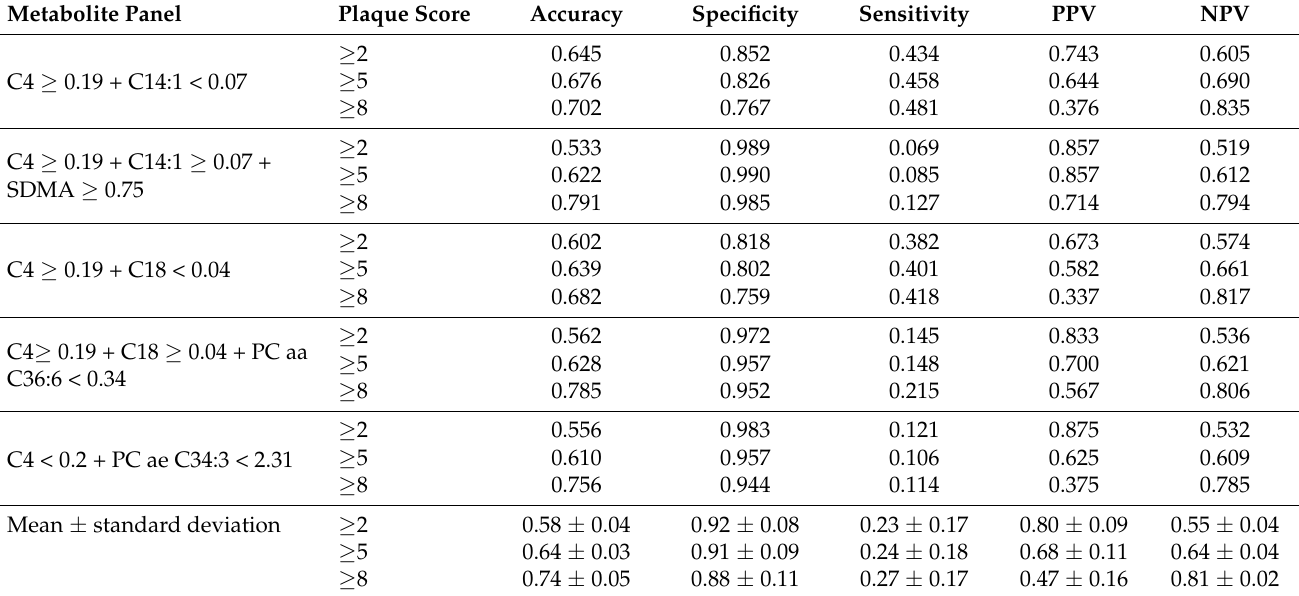
Table 3. Performance metrics of metabolite panels in the 3 subgroups of carotid artery stenosis patients among the total 349